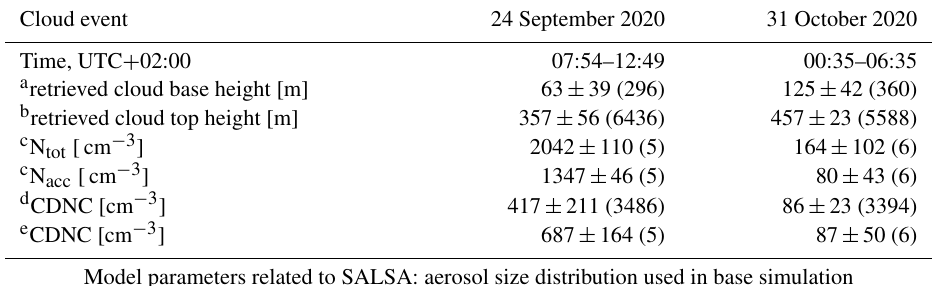
Table 1. Cloud and aerosol properties during selected cloud events that were measured at the Puijo top monitoring site. Values are reported as an arithmetic mean ± standard deviation (number of observations). N tot and N acc are aerosol number concentrations in the total size range from 27 to 1000nm, and in the accumulation mode from 100 to 1000nm, respectively. CDNC represents droplet number concentration retrieved from twin-inlet DMPS